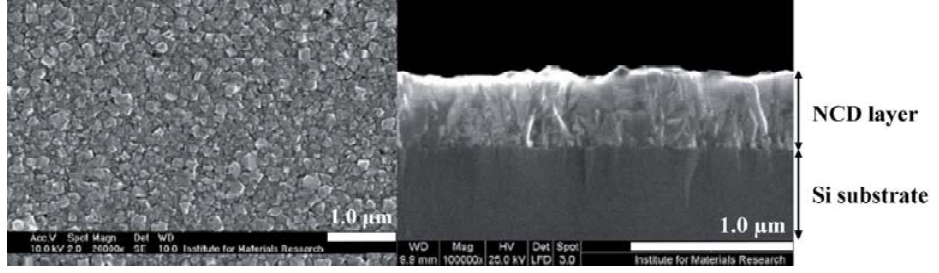
Figure 4. SEM images of a NCD film on Si. In a topographical view, the nm-sized grains on the surface are clearly visible (left panel). The cross-section shows the thinner diamond layer on top of the Si (right panel) (Institute for Materials Research, Belgium) .